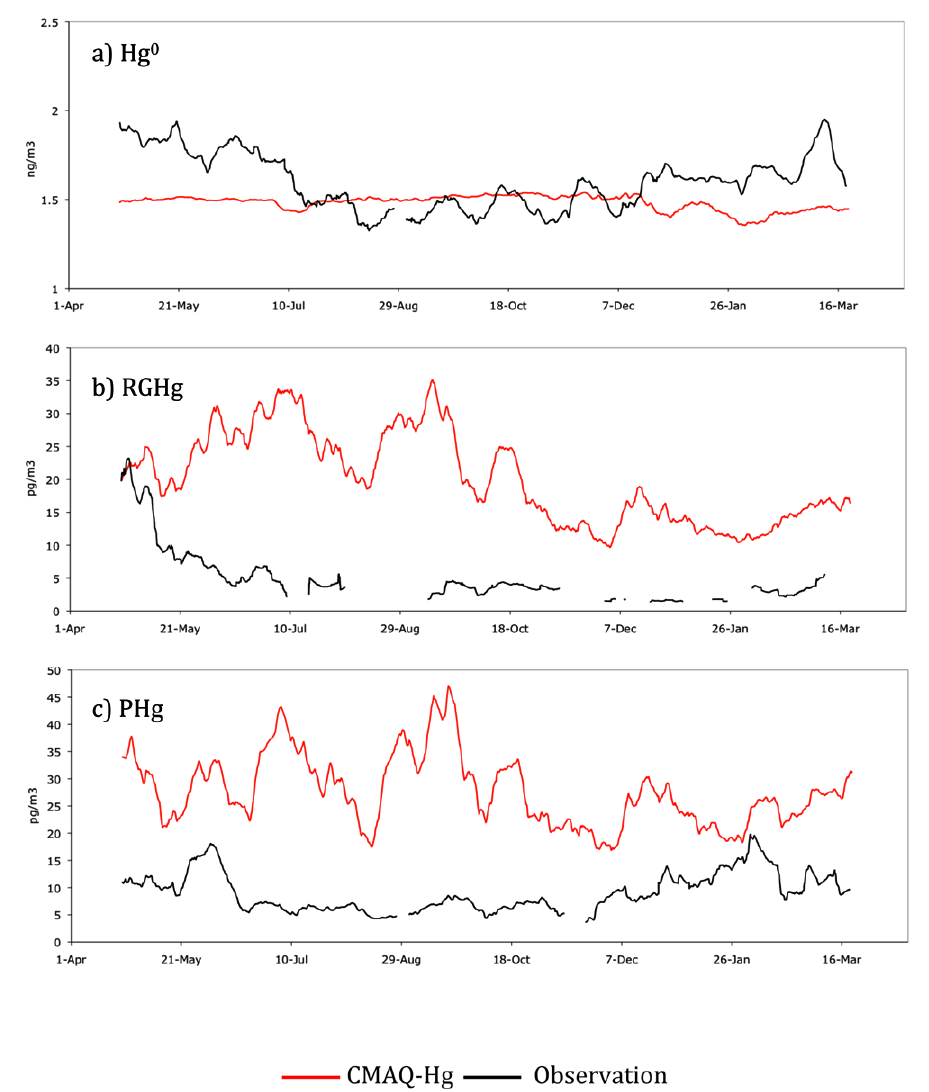
Fig. 2. Comparison of CMAQ-Hg simulated ambient mercury species against observed values at the rural DL site for Hg 0 ( a , units ngm − 3 ) , RGHg ( b , units pgm − 3 ) , and PHg ( c , units pgm − 3 ) . Values reflect a 14-day running average. Observed data spans 2003–2004; model data taken from a 2003 annual